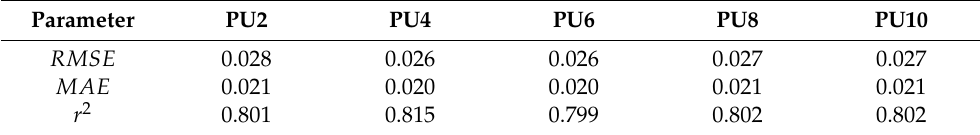
Table 2. Performance evaluation parameters of the T-GCN model.